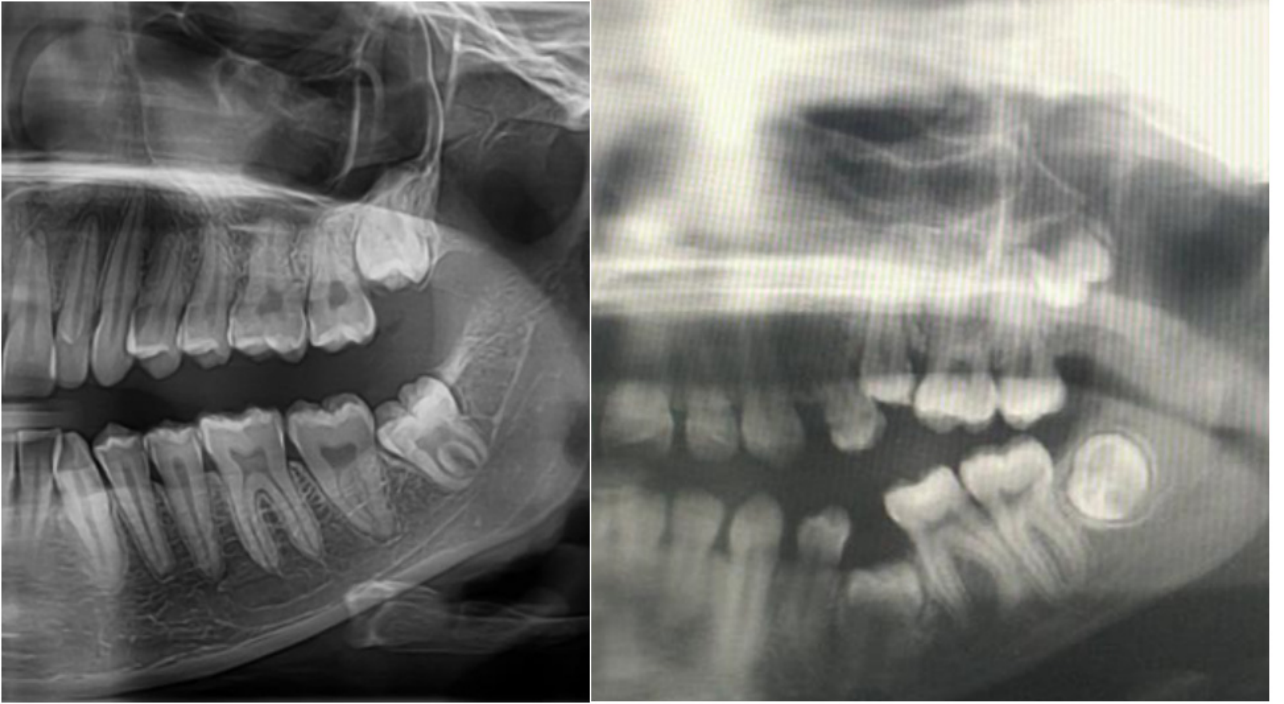
Figure 1. Panoramic radiographs illustrating the teeth of a healthy individual and an individual with osteopetrosis.